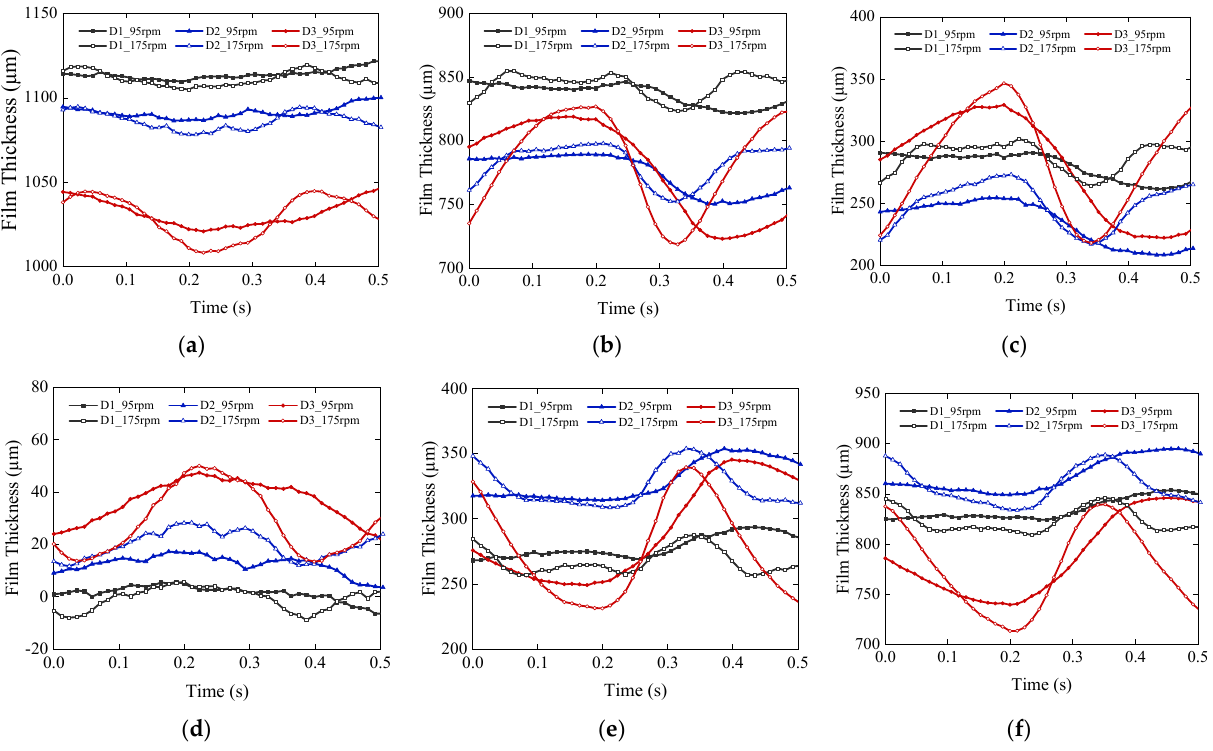
Figure 8. Film thickness at each angle of sections D 1 ~D 3 at 95 rpm and 175 rpm: ( a ) 0°; ( b ) 60°; ( c ) 120°; ( d ) 180°; ( e ) 240°; and ( f ) 300°.